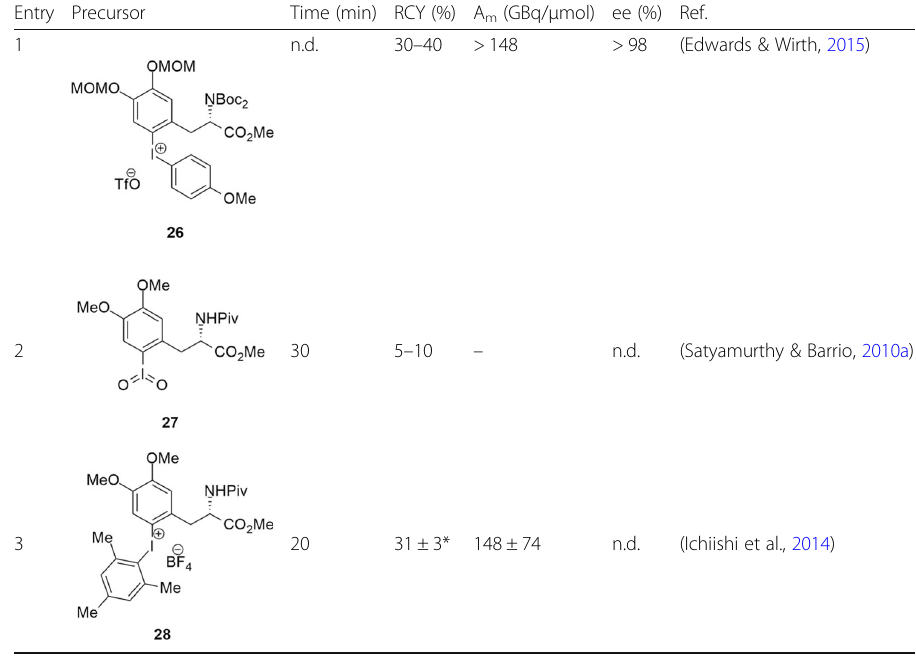
Table 3 Synthesis of 6-[ 18 F]FDOPA using iodonium salts as precursors Entry